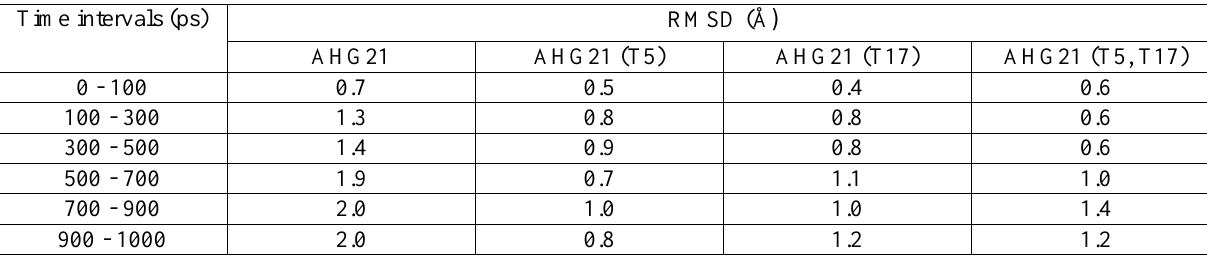
Table 1 . RMSD between coordinate sets of the backbone atoms (C α corresponding average structures during the production run of MD simulations.